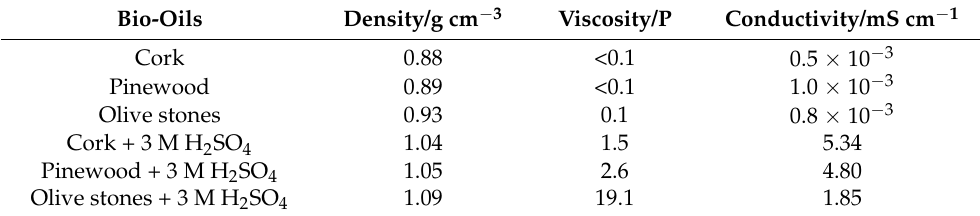
Table 3. Physicochemical properties of the bio-oil samples produced from the different biomasses before and after adding 3 M H 2 SO 4